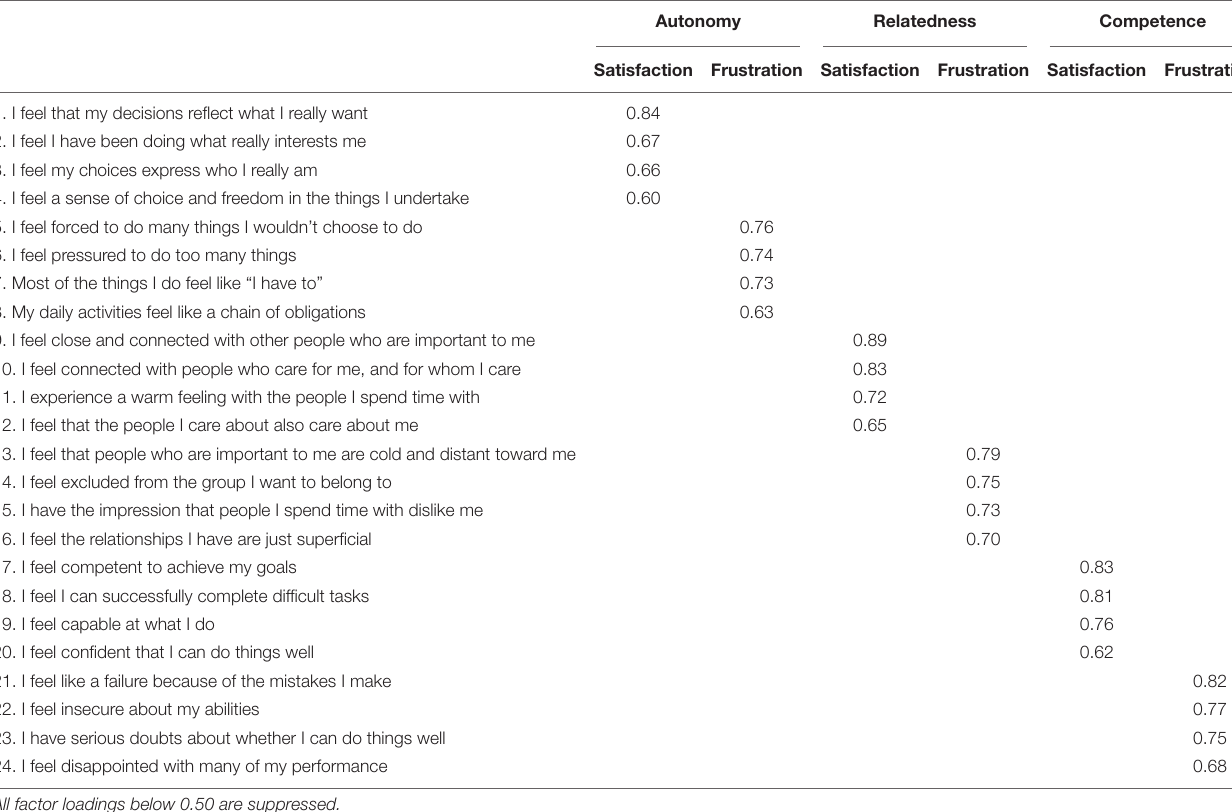
TABLE 1 | Factor loadings based on exploratory factor analysis for 24 items of the Basic Need Satisfaction and Frustration Scale ( N = 272, Study 1).